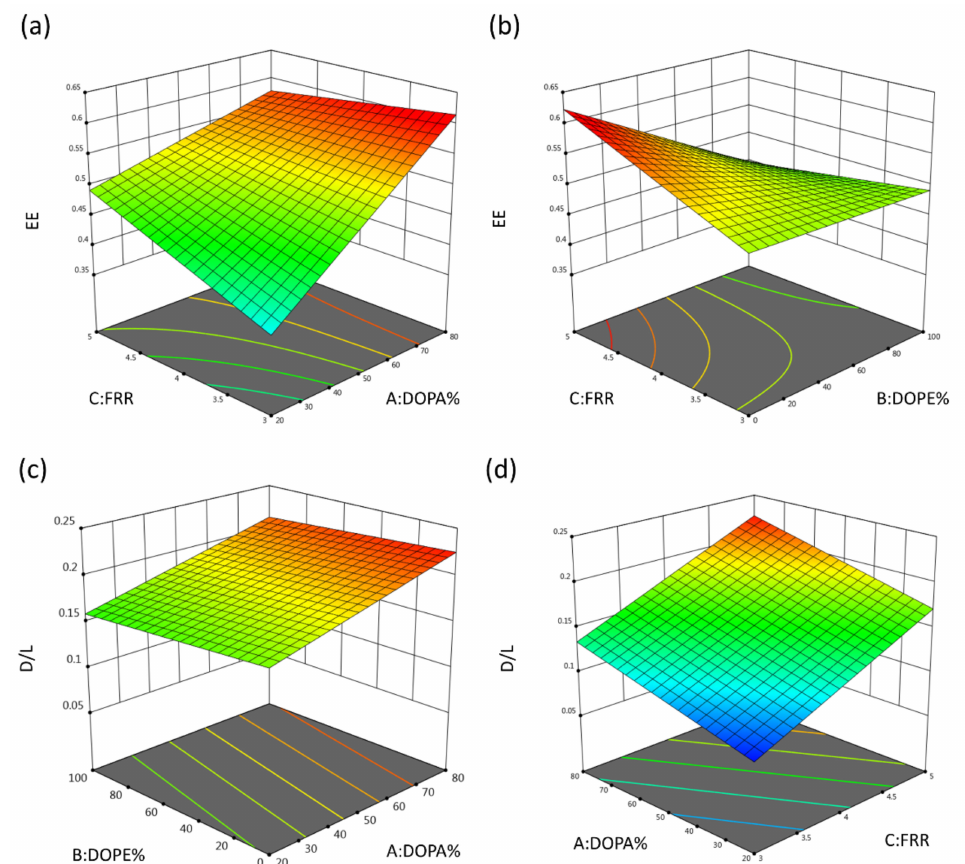
Figure 8. 3D surface plot for ( a ) interaction of DOPA% and FRR with EE%, ( b ) interaction of DOPE% and FRR with EE%, ( c ) interaction of DOPA% and DOPE% with D/L ratio, and ( d ) interaction of DOPA% and FRR with D/L